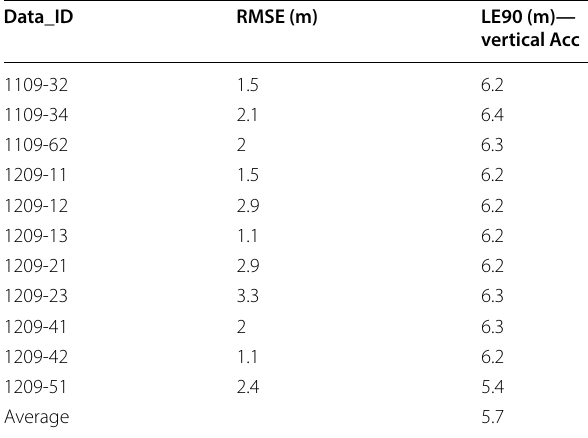
Source: Quality report of Geospatial Information Agency of Indonesia